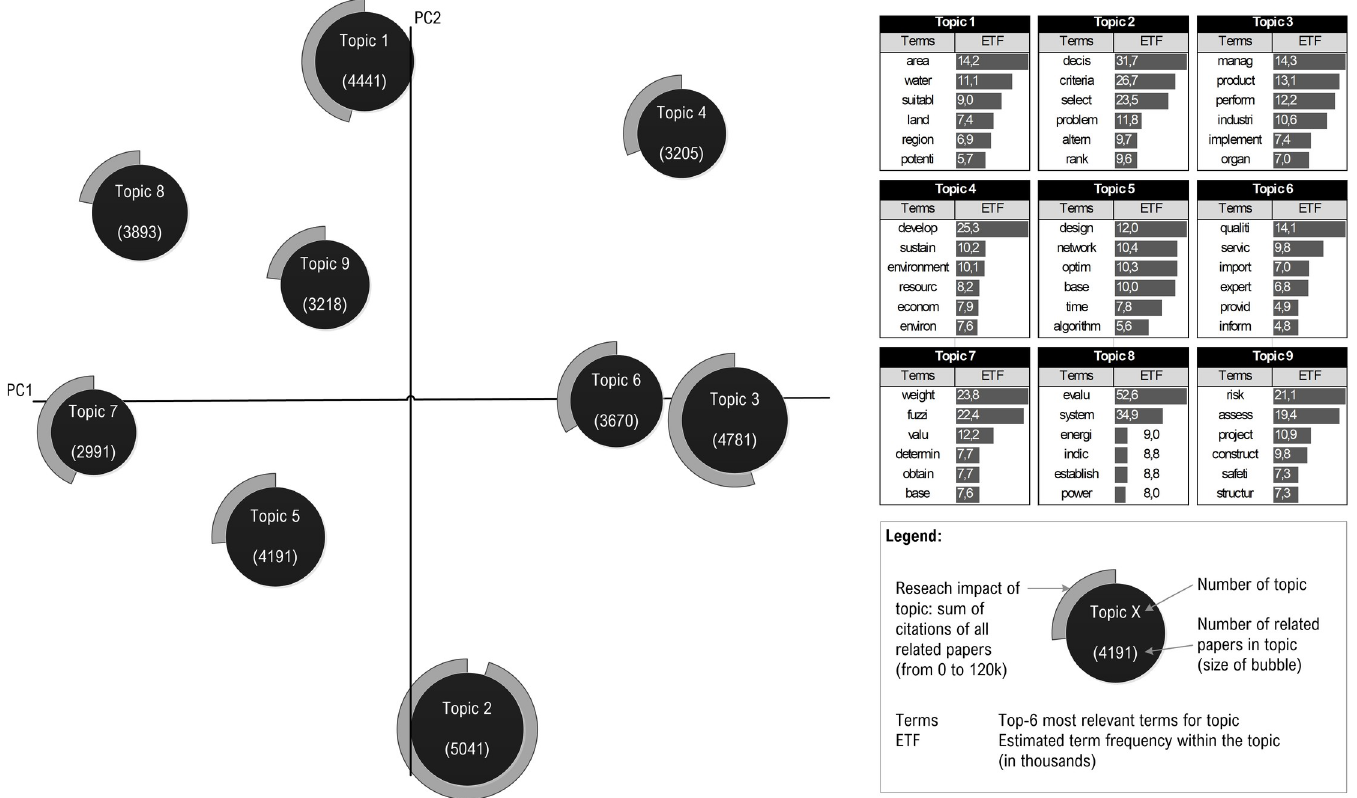
Fig 6. Intertopic distance map.